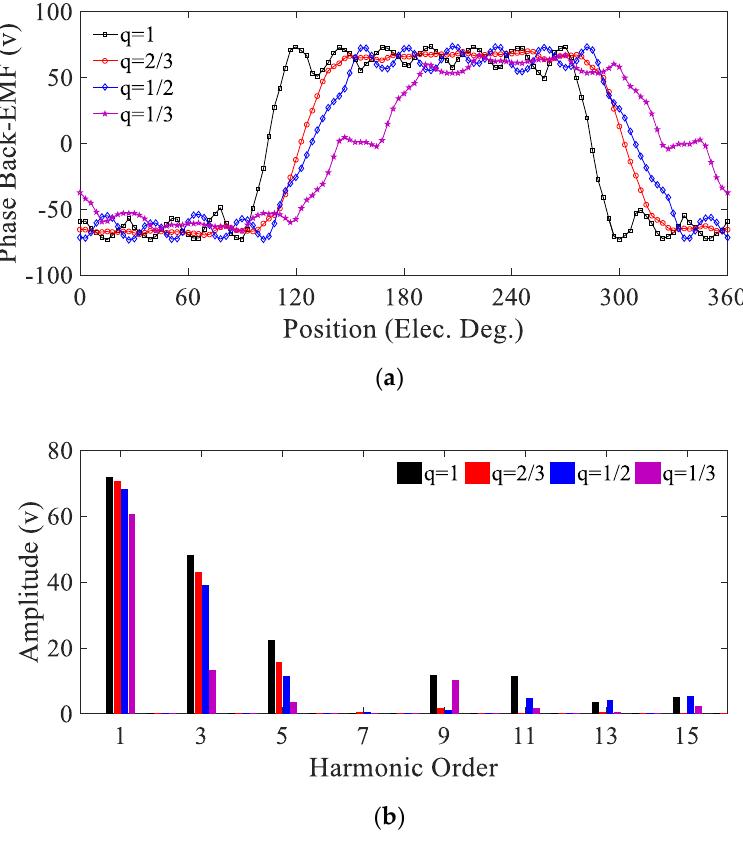
Figure 12. Initial models: ( a ) Phase Back-EMF, ( b ) Back-EMF FFT.